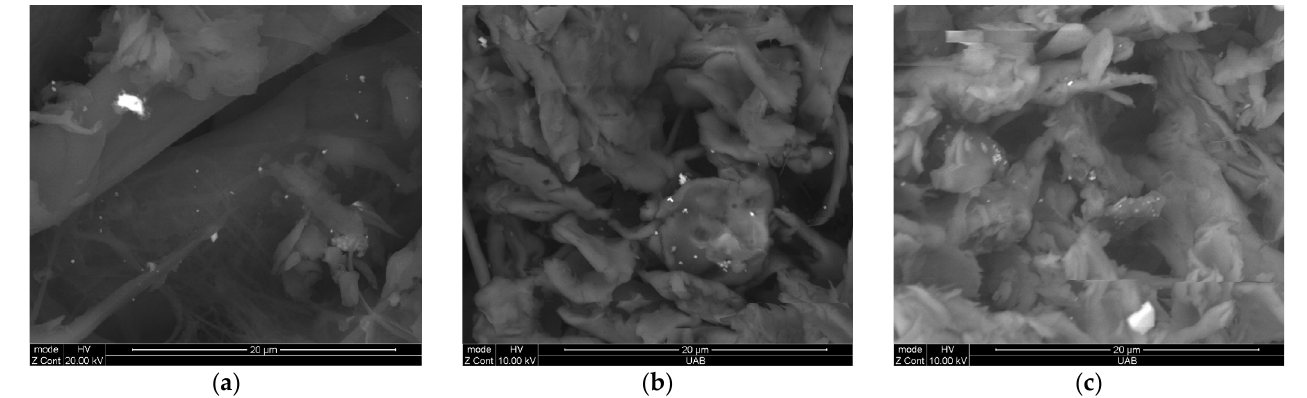
Figure 2. Backscattering SEM image of paint dust generated by sanding using P120 sandpaper after ( a ) 0, ( b ) 3, and ( c ) 12 months of environmental weathering.